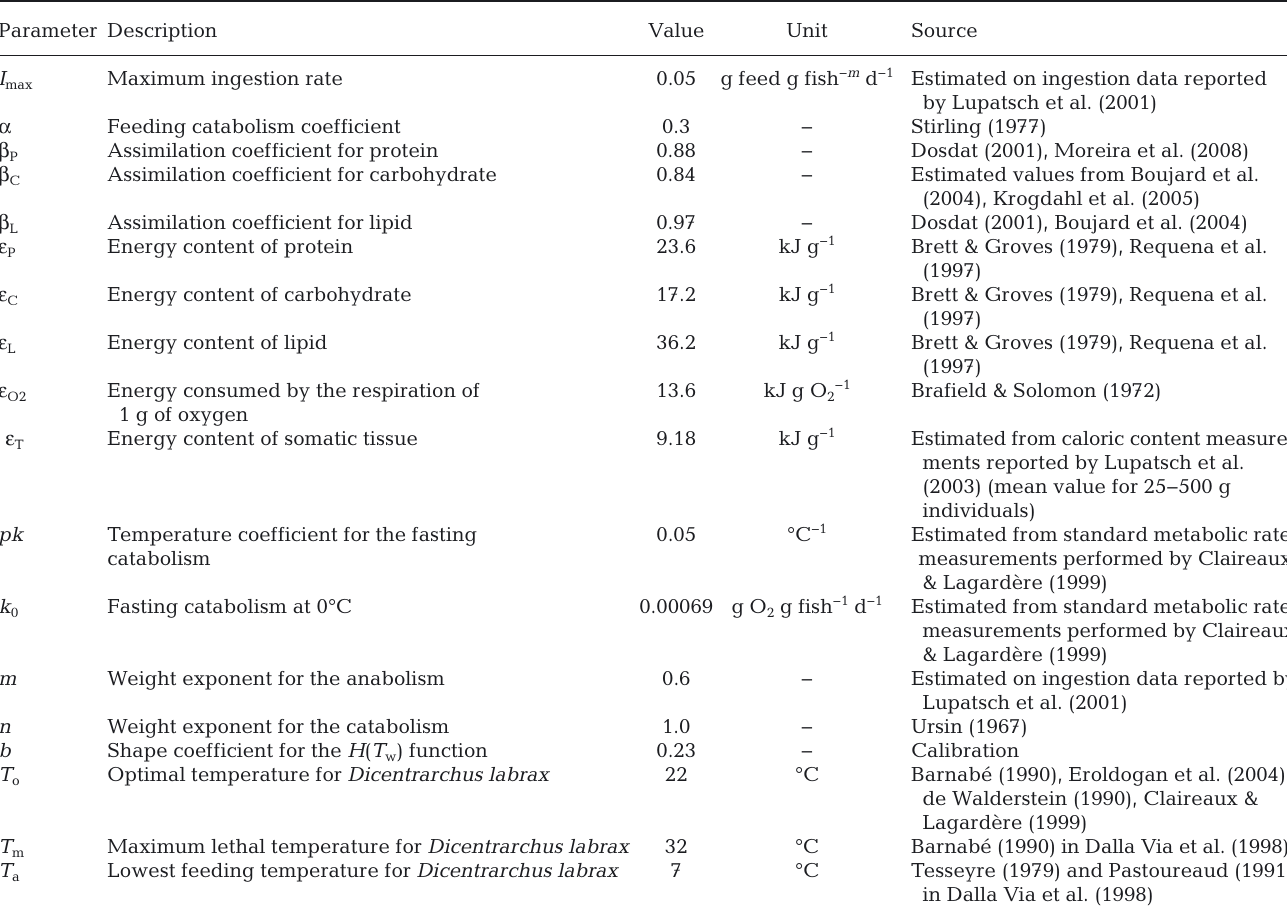
Table 1. Parameters used in the Dicentrarchus labrax growth model and their